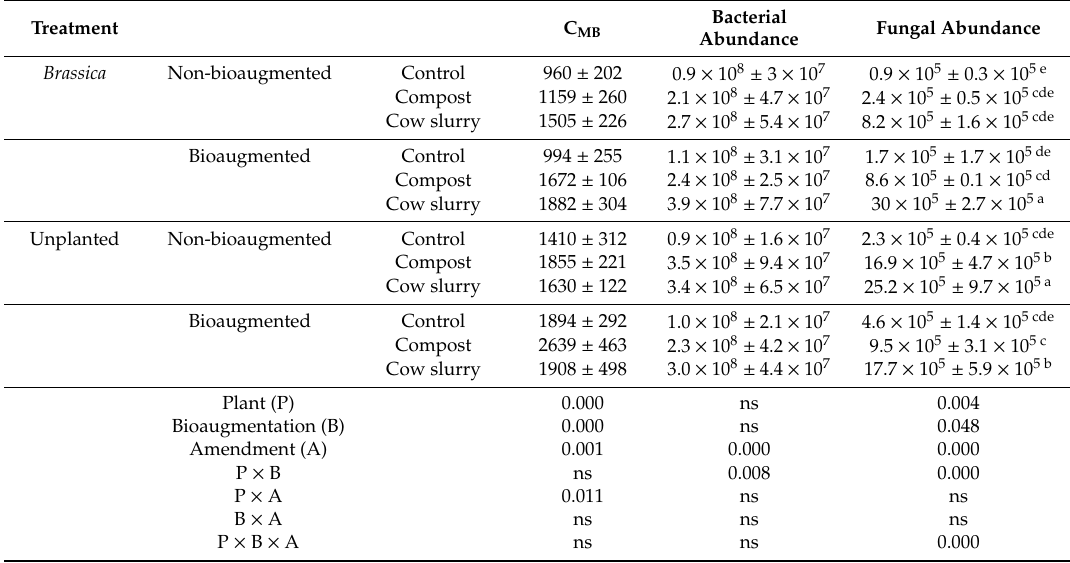
Figure 3. Biplot of the redundancy analysis (RDA) performed on soil microbial biomass parameters. 16S rRNA and 18S rRNA gene copy numbers determined by qPCR; C MB : microbial biomass C. Compost: amended with composted horse manure; Cow slurry: amended with dried cow slurry. Table 5. E ff ect of treatments on soil microbial biomass. Mean values (n = 3) ± SD. Probability values from three-way ANOVA (ns: non-significant) for the e ff ects of plant growth, bioaugmentation, amendment and their interactions are shown below. When the triple interaction is significant, the means with di ff erent letters are significantly ( p < 0.05) di ff erent according to Duncan’s test. C MB : microbial biomass C (mg C kg − 1 DW soil); Bacterial and fungal abundances (gene copy numbers by qPCR). Compost: amended with composted horse manure; Cow slurry: amended with dried cow